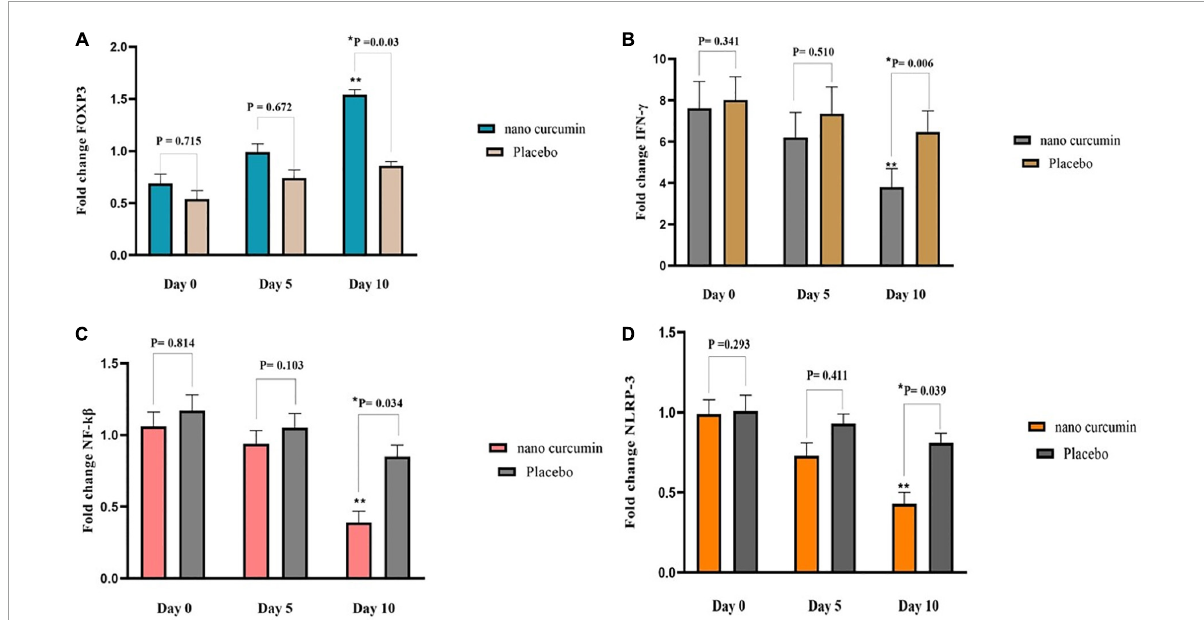
FIGURE2 The effects of the intervention on FOXP3, NLRP3, IFN- γ , and NF-k β expression in two study groups. (A) Fold change of FOXP3 (B) fold change of NLRP3 (C) fold change of IFN- γ (D) fold change of NF-k β . Values are mean of fold change ± SEM. Data analysis was done using the ANCOVA test (adjusted for sex, age, type of disease, and baseline values; * p < 0.05 vs. placebo) and Repeated measures ANOVA (** p < 0.05 vs. baseline). P < 0.05, statistically significant. FOXP3, forkhead box P3; NF- κ B, nuclear factor kappa B; NLRP3, NLR family pyrin domain containing 3; IFN- γ , interferon